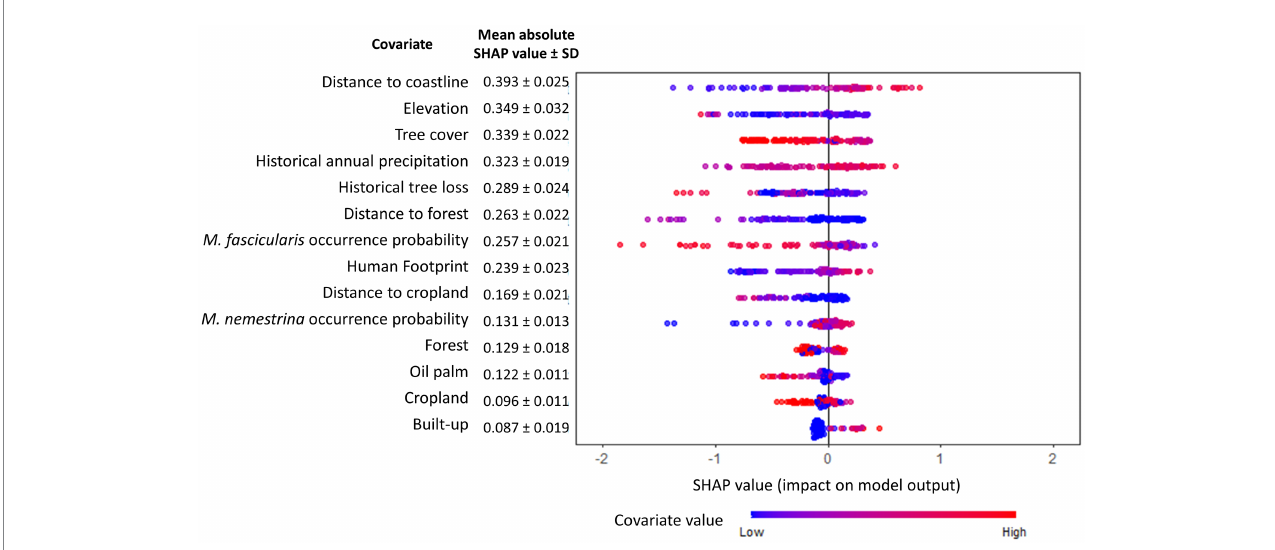
FIGURE 4 Global SHAP summary plot. The relative importance of each covariate toward human knowlesi malaria risk is indicated and ordered (most important covariate at the top) by the mean absolute SHAP value summarized over 30 model replicates. Warmer dot color indicates higher value of corresponding covariate.